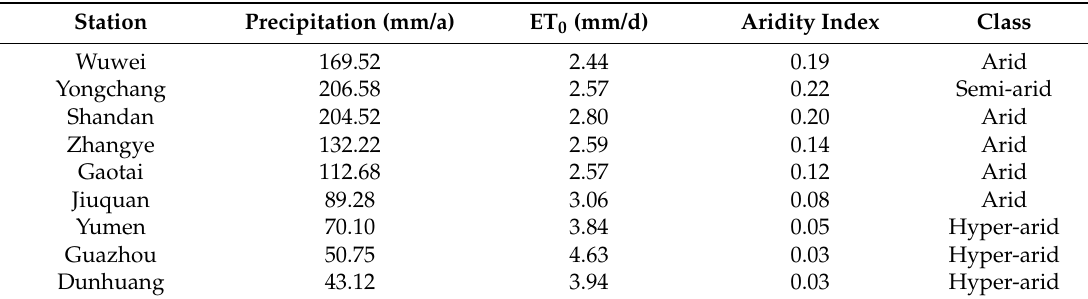
Table 5. Aridity index calculated using FAO-56 Pemman-Monteith